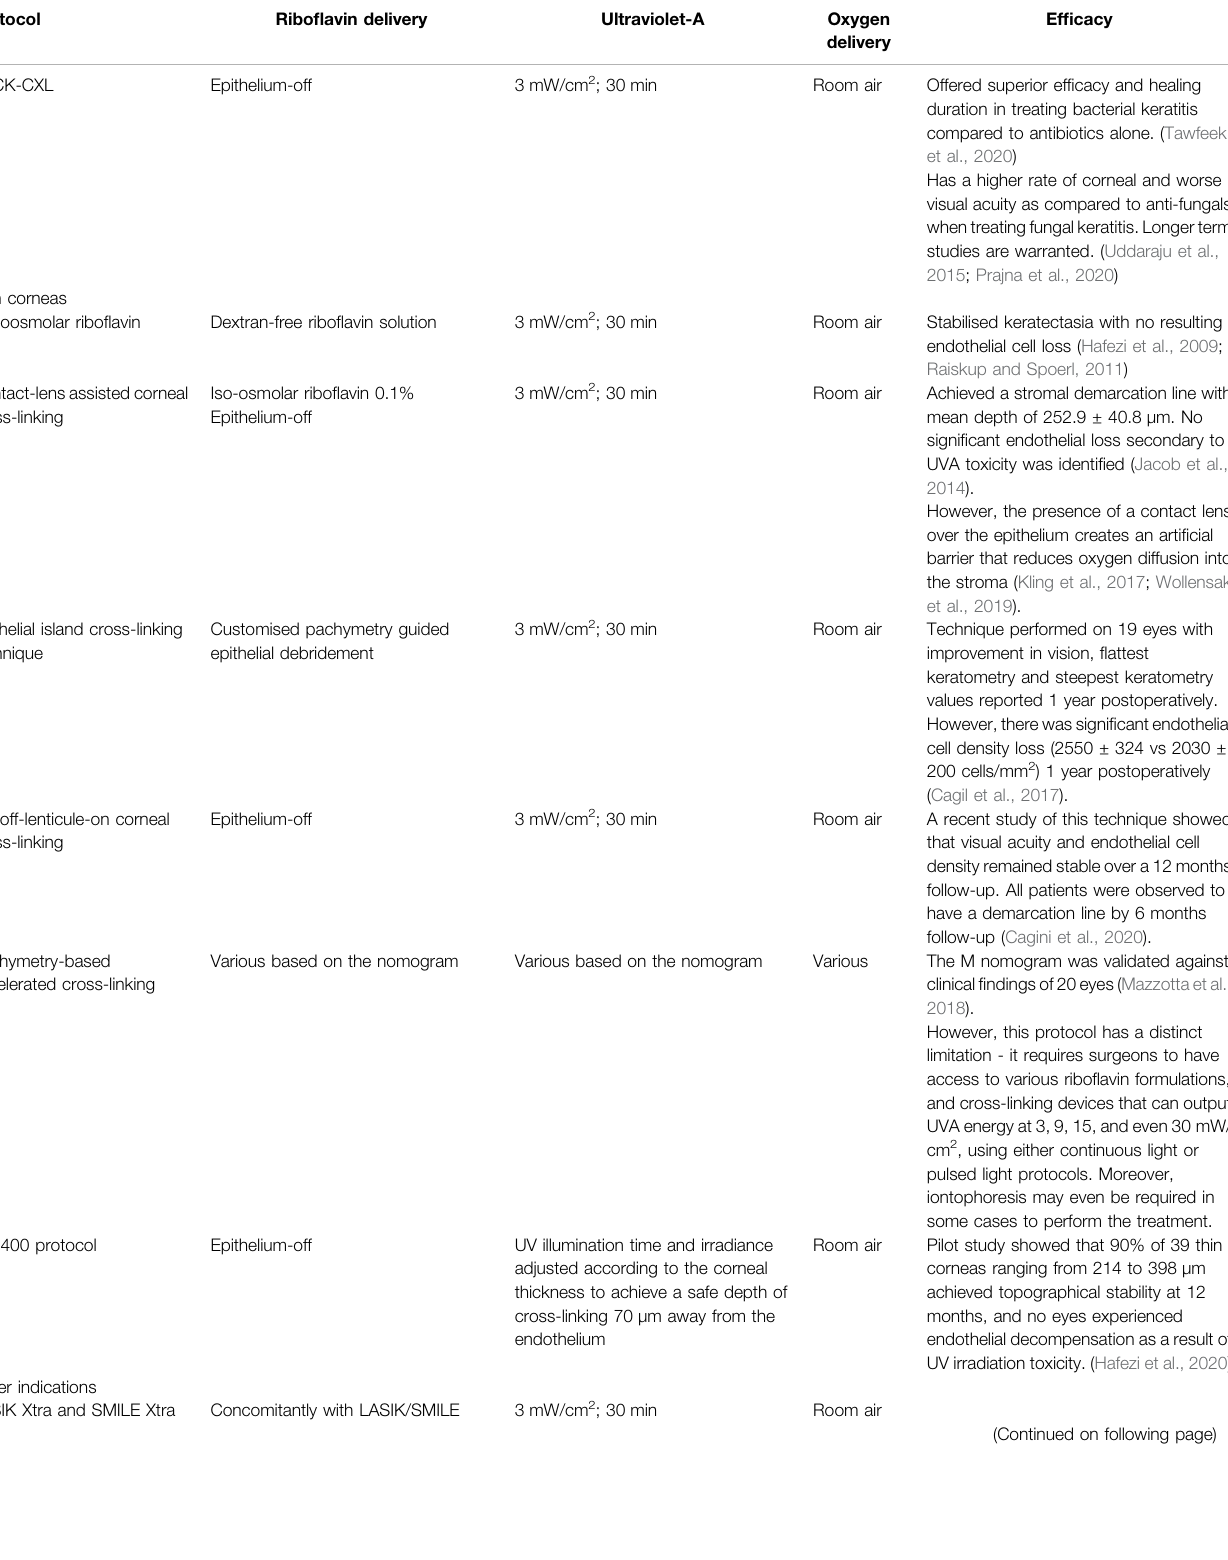
TABLE 1 | ( Continued ) Summary of existing corneal cross-linking